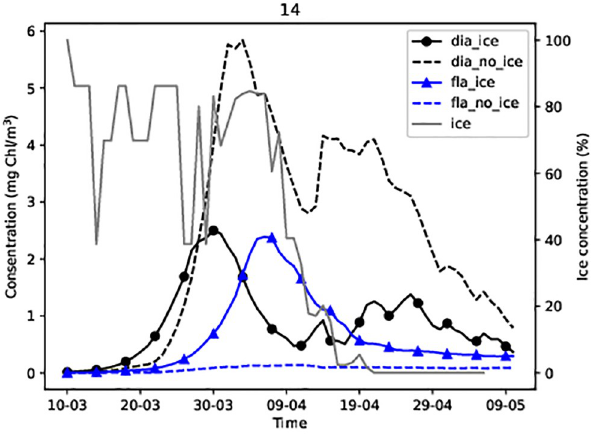
Fig 4. Simulated diatom and dinoflagellate concentrations at station